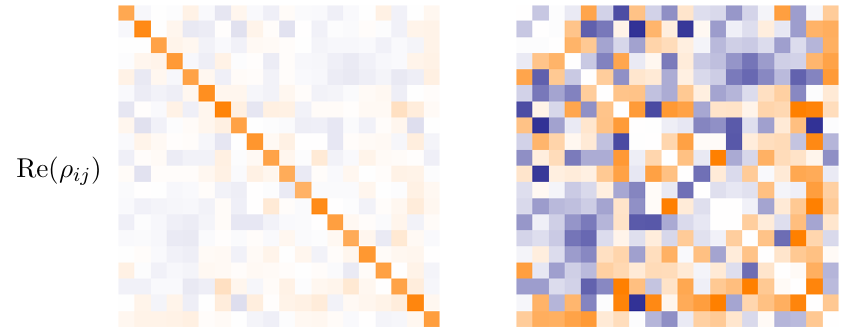
20 and e S 50 (left). Orange is positive and blue (cid:16) (cid:16) k e S { 2 . {